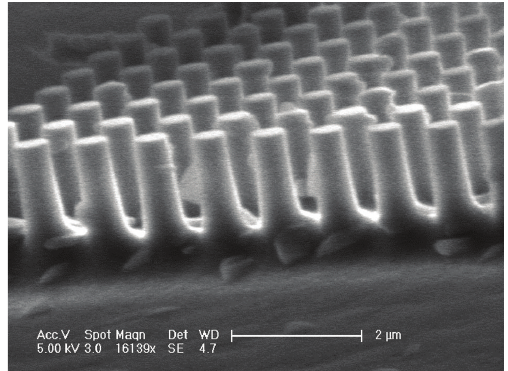
Figure 6: Nanopillars etched in CMOS top metal pads.